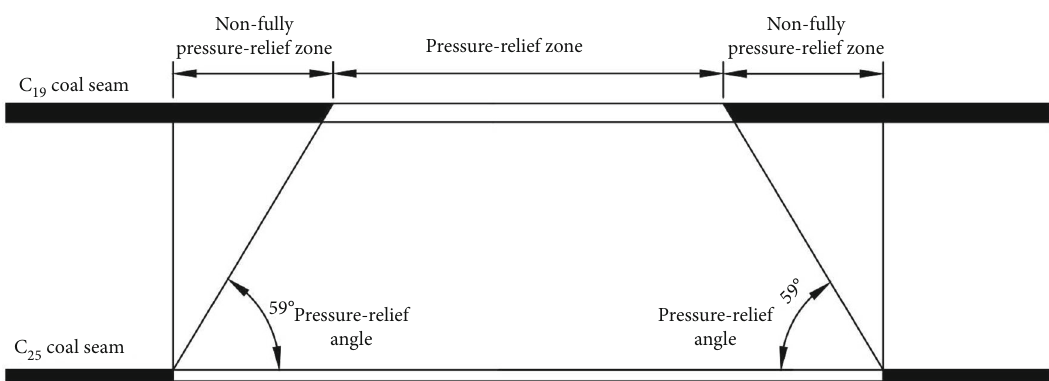
Figure 10: Pressure-relief angle and corresponding zones of protected layer.